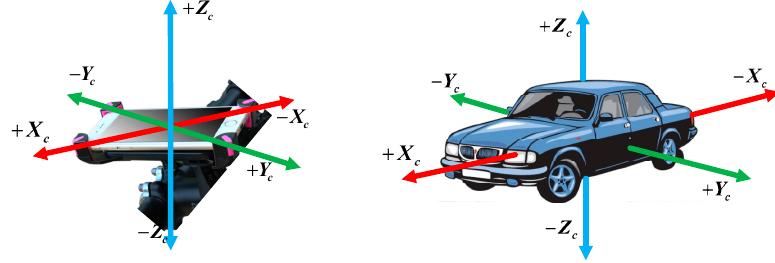
Figure 2. Smart-phone parallel mounted tightly in a vehicle.